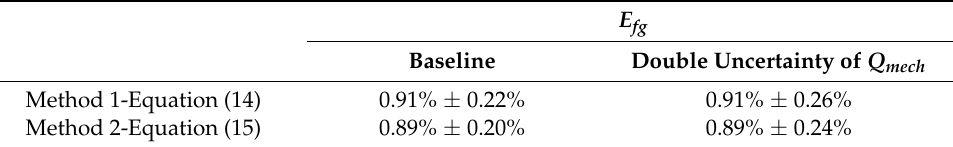
Table 2. E fg and its uncertainty at 700 RT and 581 kg charge.